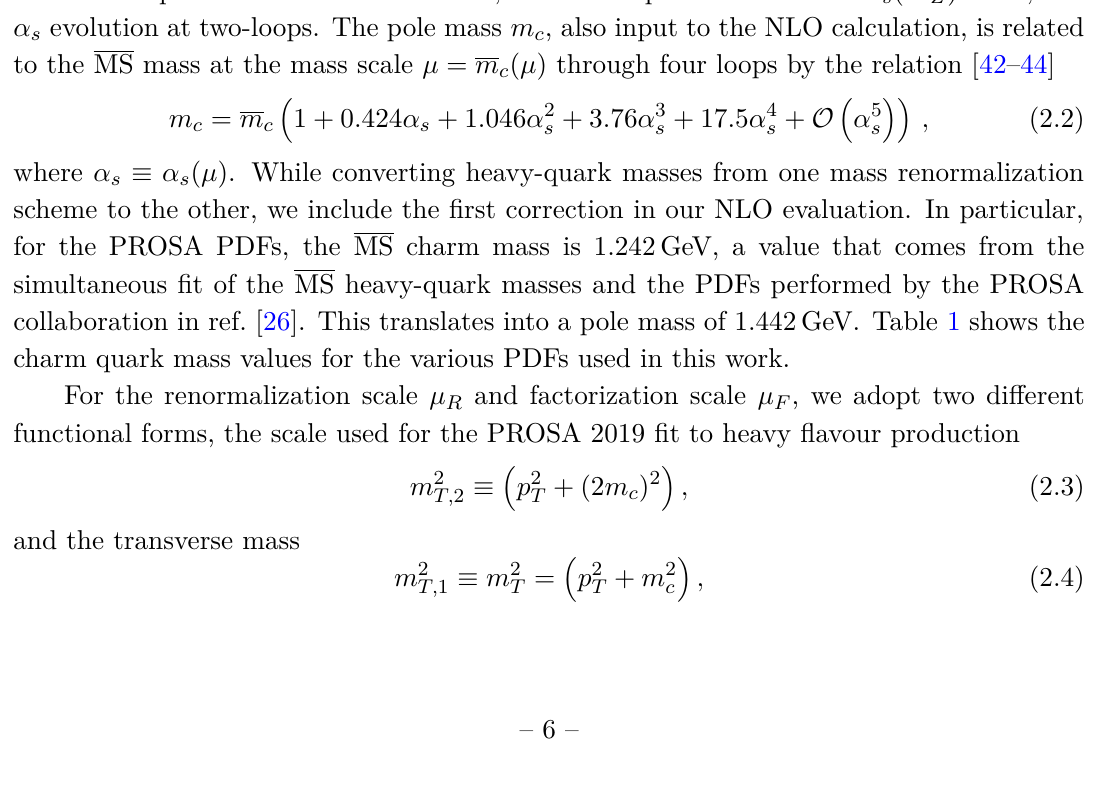
Figure 1. Effect of two different implementations of the fragmentation of a c -quark into a D − meson, in the D − rapidity y (upper left), transverse momentum p T (upper right) and energy E s √ distributions (lower) at a pp collider with s = 14 TeV, for h k T i = 0 GeV. For facilitating the comparison with the c -quark distributions, the fragmentation fraction of charm quark to D − to 1. In the second plot, the collider and parton CM frame p T distributions are identical. See text for more detail on the fragmentation options in the collider CM frame and parton CM